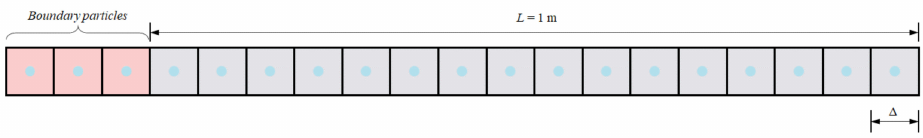
Figure 7. Geometry of a bar and its